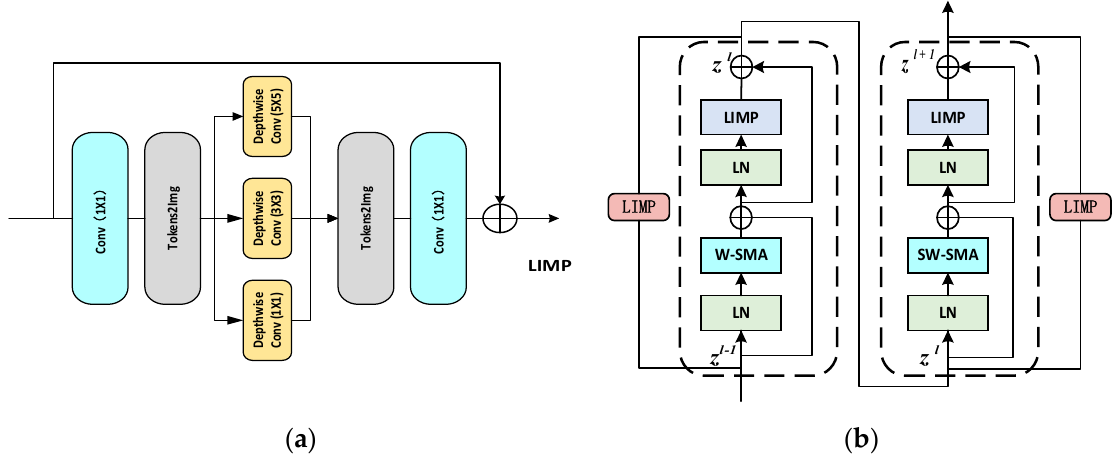
Figure 5. Structure in WaterFormer block. ( a ) Structure of LIMP module, ( b ) structure of the WaterFormer Block.